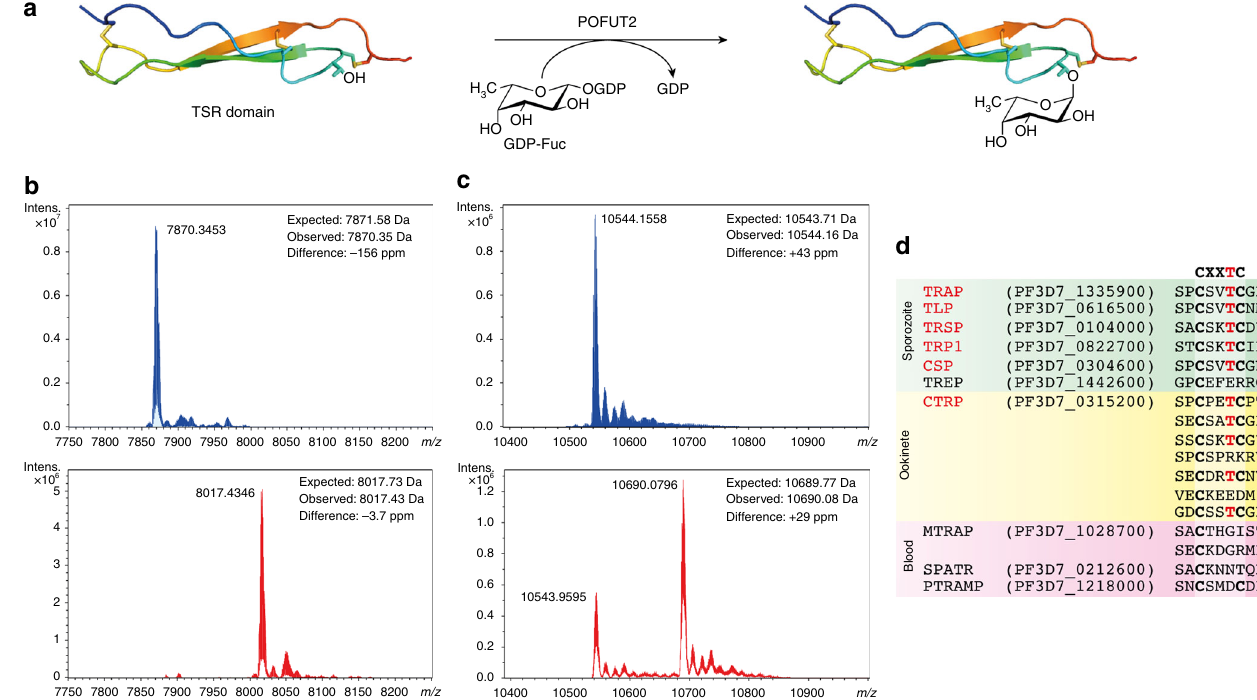
Fig. 1 O-Fucosylation of TSR domains by POFUT2 in P. falciparum . a O-Fucosylation of TSR domains by GDP-fucose, as catalyzed by POFUT2, (illustration generated using 4HQO) 25 . b Deconvoluted intact ESI mass spectrum of recombinant P. falciparum TRAP TSR domain treated with GDP-fucose in the absence ( blue ) and presence ( red ) of P. vivax POFUT2. c Deconvoluted intact ESI mass spectrum of recombinant P. falciparum CSP TSR domain treated with GDP-fucose in the absence ( blue ) and presence ( red ) of P. vivax POFUT2. d Multiple sequence alignment of all TSR domain sequences from P. falciparum revealing the proteins that are likely to be O-fucosylated ( red ) and in what parasite stage they are